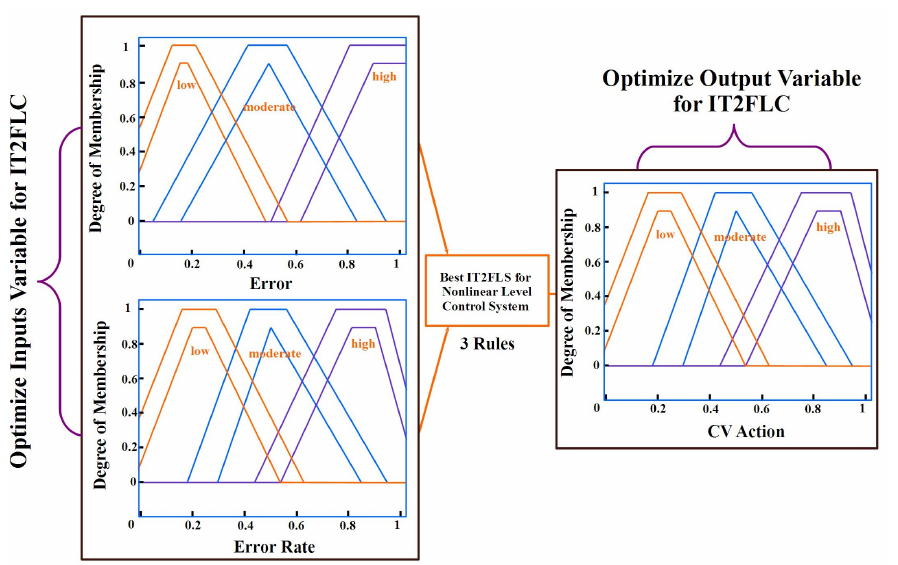
Figure 10. Best/Optimize IT2FLS that FP algorithm using ST2FIS finds for the frustum two-tank fuzzy